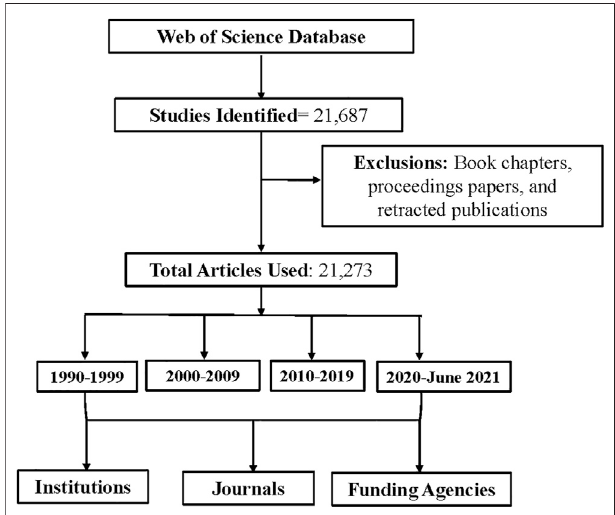
FIGURE 1 | This fl owchart show methods and parameters used to design this